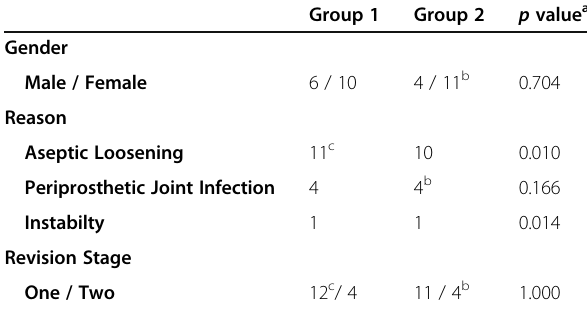
Table 1 Etiological factors for